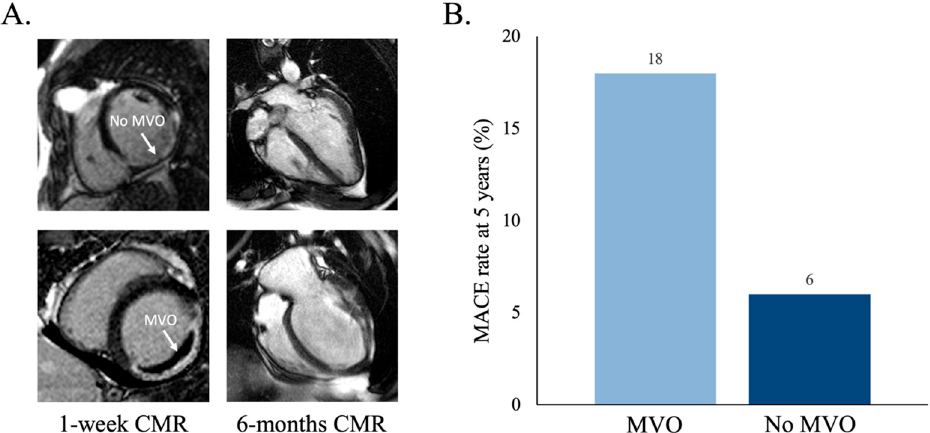
Figure 4. Clinical and structural consequences of microvascular obstruction (MVO) as derived from cardiovascular magnetic resonance (CMR) in ST-segment elevation myocardial infarction patients. ( A ) A CMR after 6 months, showing that more severe left ventricular remodeling and systolic deterioration occurs in patients with MVO (lower panel) compared with those without MVO (upper panel) at 1-week CMR (adapted from 7). ( B ) Patients with MVO at pre-discharge display a higher rate of major adverse cardiac events (MACE; death, re-infarction, or re-admission for heart failure) during follow-up than those without MVO (updated from [24]).